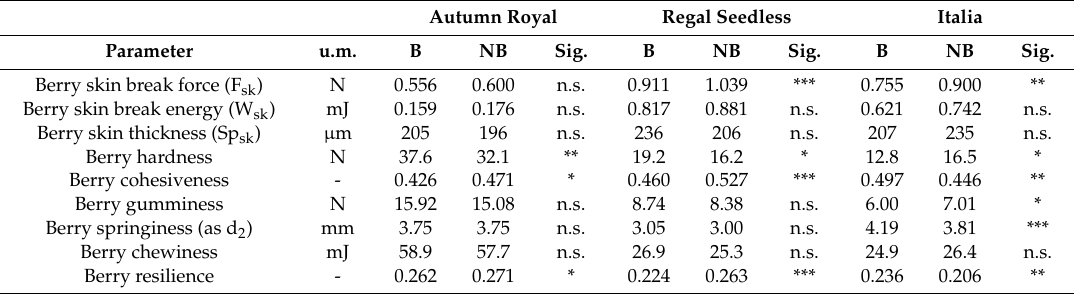
Table 5. Mechanical properties of bagged (B) and not bagged (NB) berries at harvest as induced by the